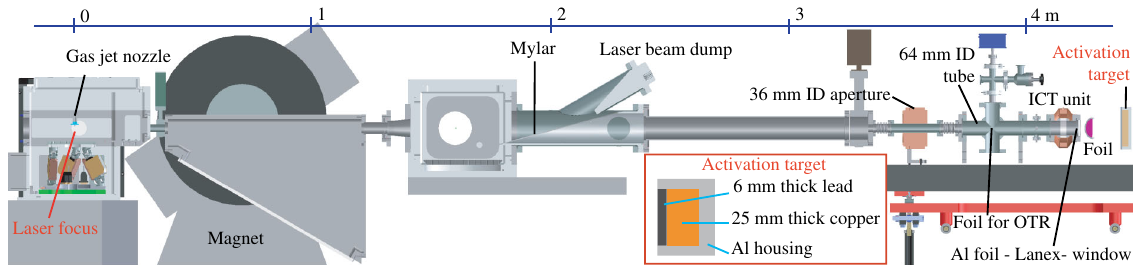
FIG. 7. Setup for the charge cross calibrations with LPA produced e-beams. The laser pulse was focused onto a supersonic gas jet. The laser pulse was reflected toward a laser beam dump by an aluminum coated Mylar foil. An aperture with a 36 mm inner diameter was installed about 3.6 m away from the interaction point. An aluminum coated 5 (cid:1) m thick pellicle foil was located about 3.9 m for an optical transition radiation experiments (OTR foil). The identical ICT unit described in Fig. 2 followed by the borosilicate vacuum window, was installed at the end of the vacuum tube. The Lanex Fast Front was placed on the window inside of the vacuum tube, upstream of which was covered by a ’ 40 (cid:1) m thick aluminum foil. The light from the Lanex was observed by a CCD camera (not shown) through the reflection of an aluminum coated 5 (cid:1) m thick pellicle foil places with a 45-degree angle. Shown in the inset is the activation target that consisted of the 6 mm thick lead and the 25 mm thick copper in the aluminum